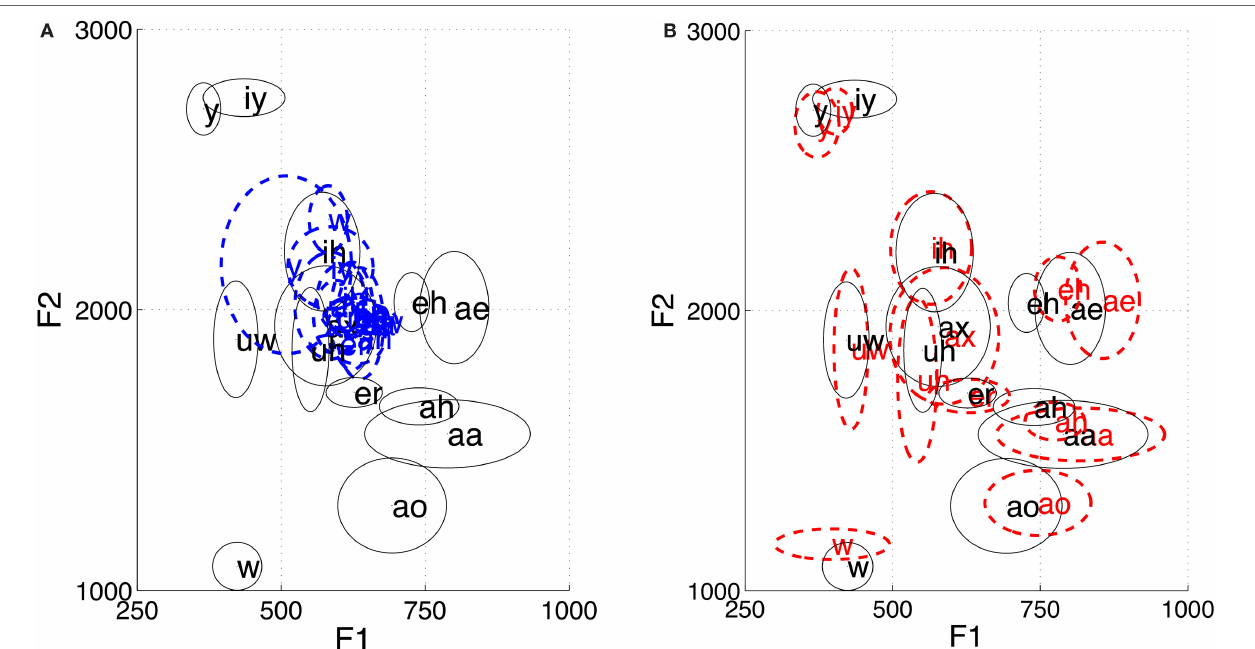
FIGURE 12 | Illustration of the effect of hyper/hypo transformations on the F1–F2 distribution of vowel formant resonance frequencies (in hertz). The distribution for untransformed vowels are shown with black lines. The distribution for hypo vowels are shown with blue-dashed lines (A) , and the distribution for hyper vowels are shown with red-dashed lines (B) . Formant frequencies were extracted using ‘Praat’ (http://www.fon.hum.uva.nl/praat/) and phone labels are displayed using the ‘CMU Pronouncing Phoneme Set’